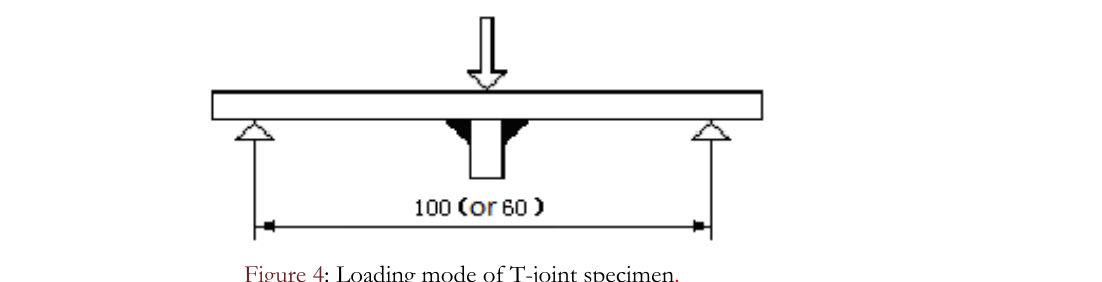
Figure 4: Loading mode of T-joint specimen.